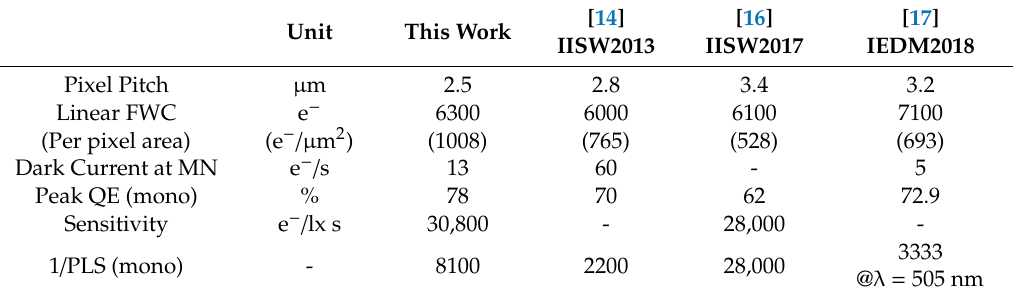
Table 4. Comparison table with previous report. FWC: full well capacity, QE: quantum e ffi ciency.